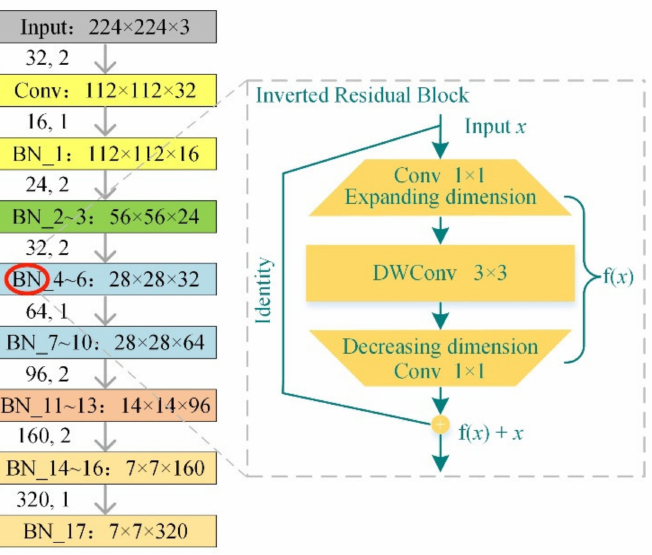
Figure 5. Structure of MobileNet-V2. The parameters next to the silver-gray downward arrow represent the number and stride of convolution kernels. BN represents Inverted Residual Block. DWConv is Depthwise Convolution, which is an important part of depthwise separable